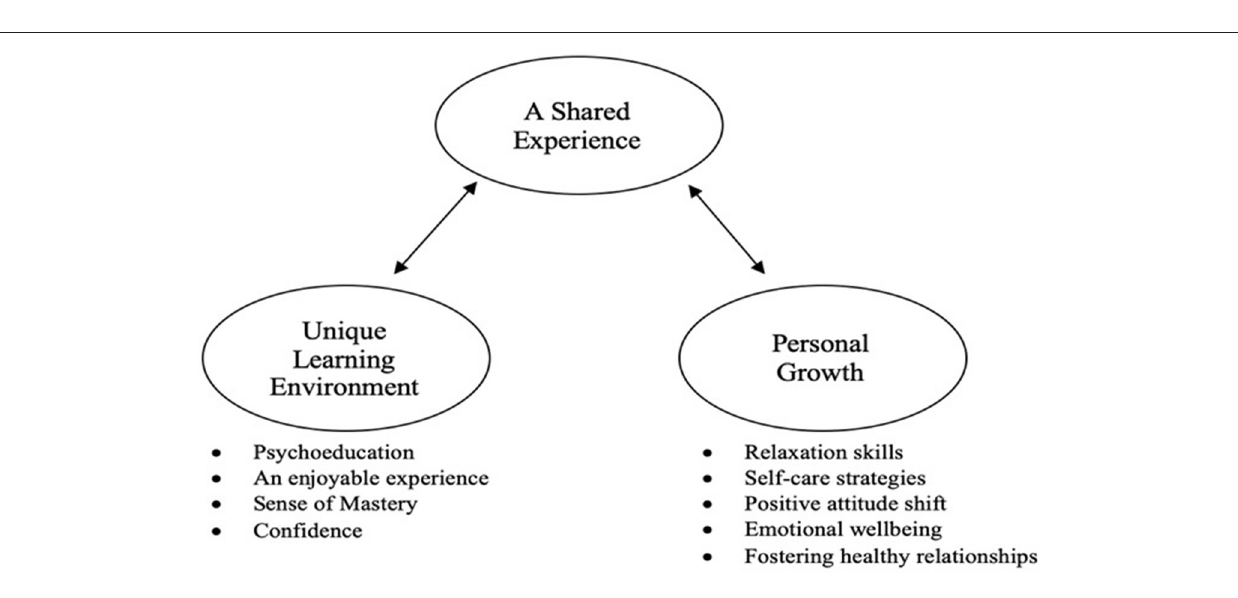
FIGURE 3 | Thematic map of participant experiences in the WOW surf